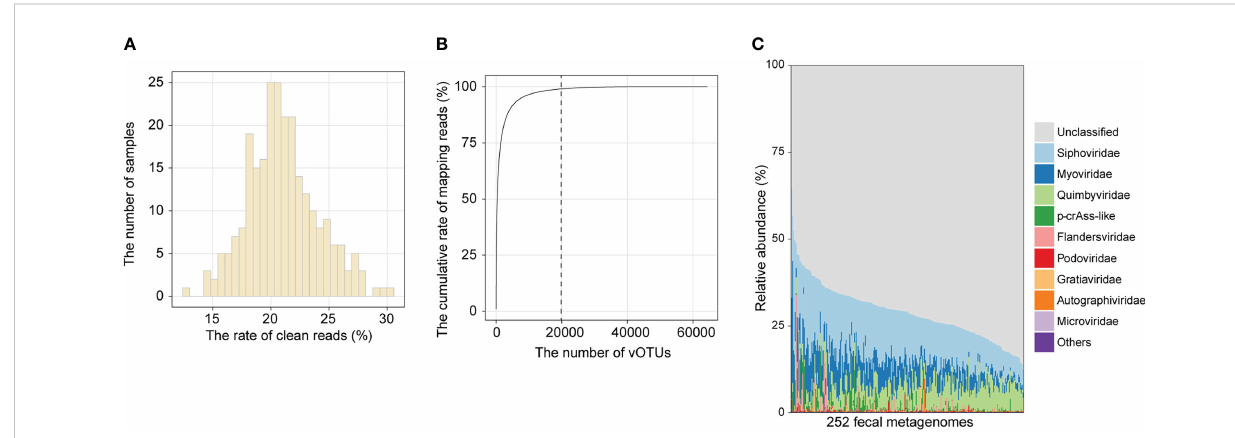
FIGURE 1 Overview of the gut viral community. (A) Histogram showing the proportion of metagenomic reads mapped to cnGVC. (B) The accumulative rate of mapping reads as a function of the number of vOTUs. A total of 67,096 vOTUs were sorted in descending order based on their average relative abundance across all metagenomic samples. (C) The gut viral composition of all samples at the family